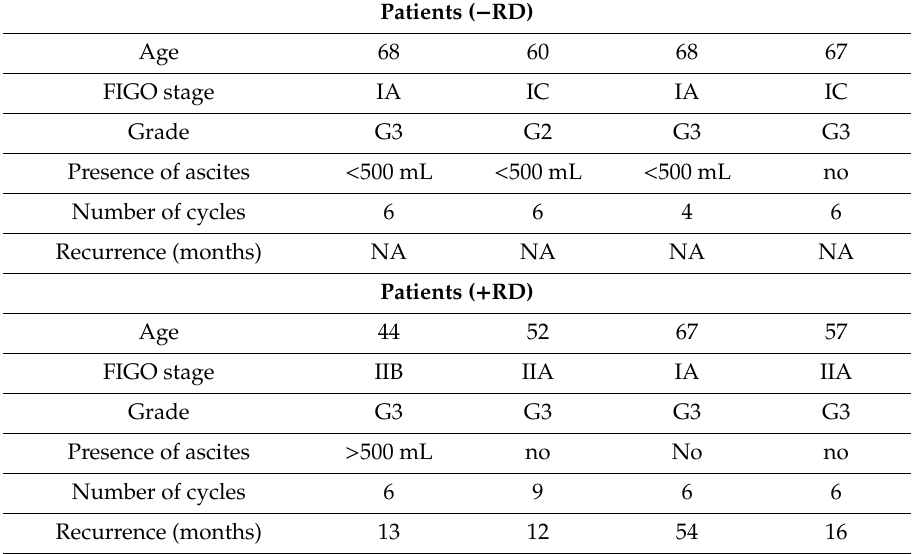
Table 2. Clinicopathological characteristics of patients. All patients received adjuvant chemotherapy for numbers of cycles as indicated in the table. Follow-ups of patients were performed for at least 5 years, if no relapse occurred, or till development of recurrent disease